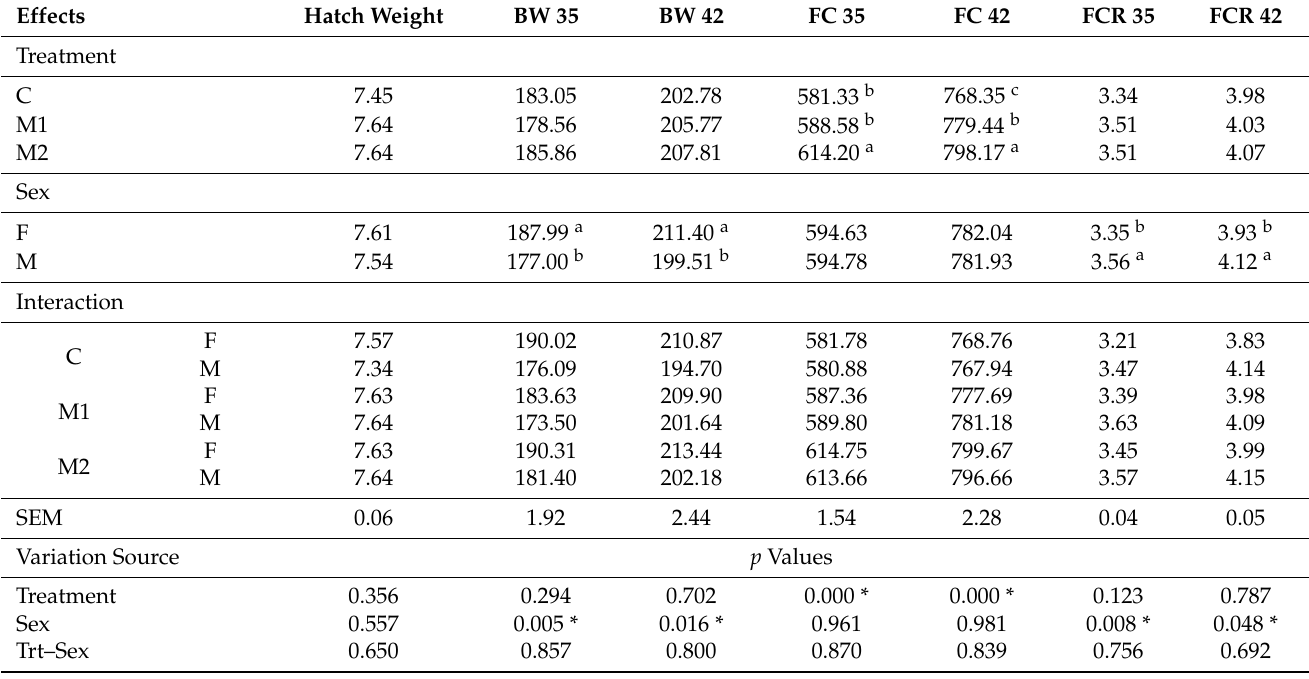
Table 3. The mean values of some performance traits and results of variance